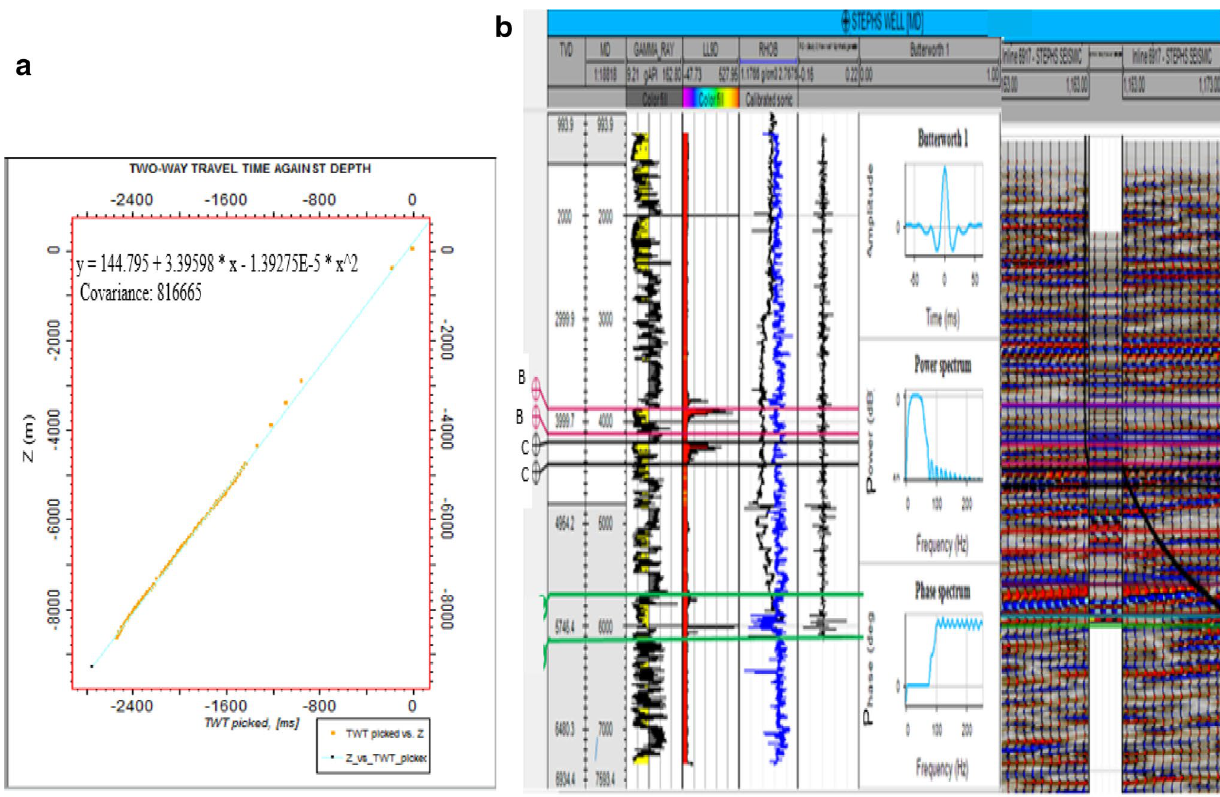
Fig. 7 a Depth ( Z ) against two-way travel time. b Synthetic seismogram and